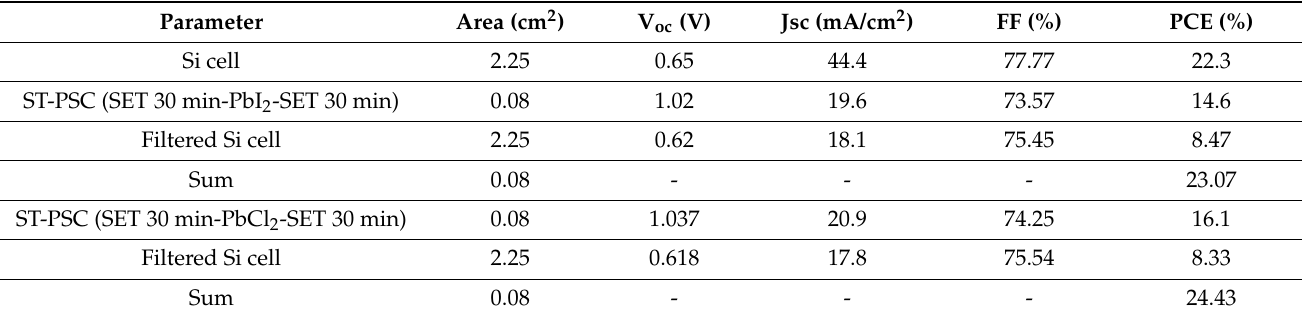
Table 5. Summary of the photovoltaic parameters of the semitransparent perovskite cell, silicon cell, filtered silicon cell, and the summed 4T perovskite/silicon tandem solar cell.